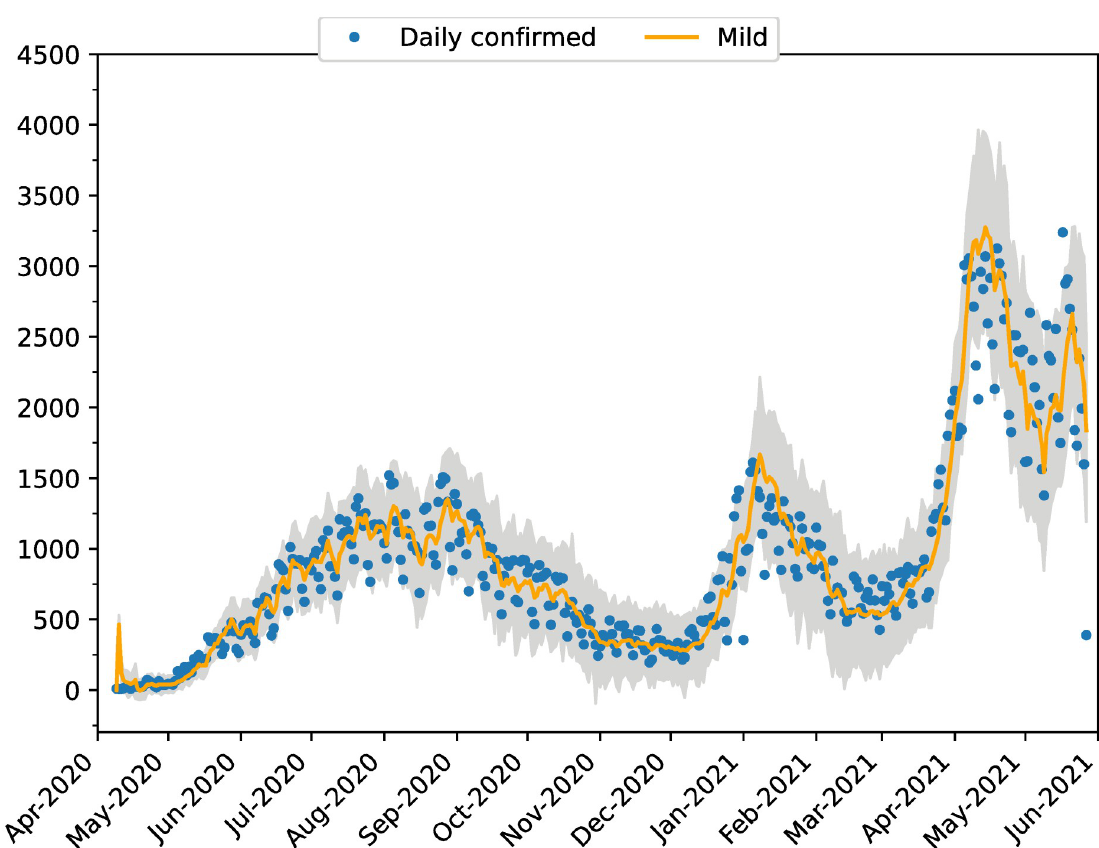
Fig 13. Total daily new cases. Estimated daily new cases for the whole city are shown with orange lines and the corresponding ensemble with gray. Blue dots correspond to the daily confirmed cases.